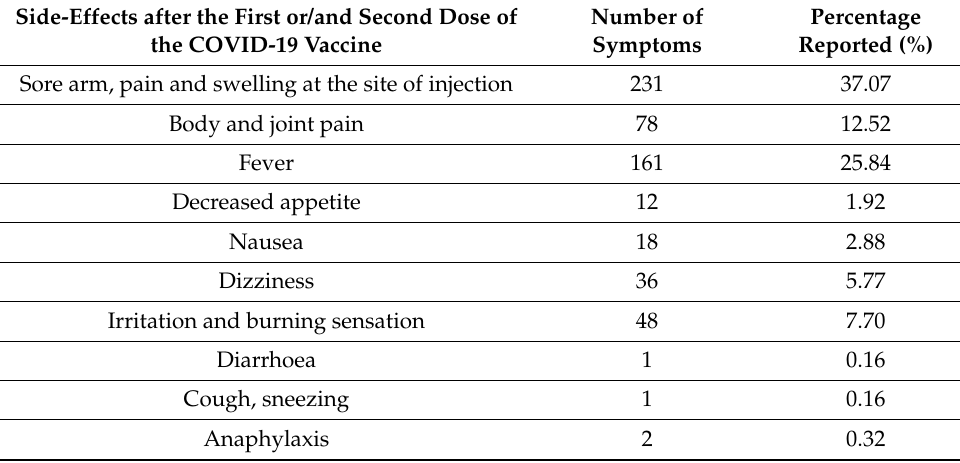
Table 3. Side-effects after administration of the COVID-19